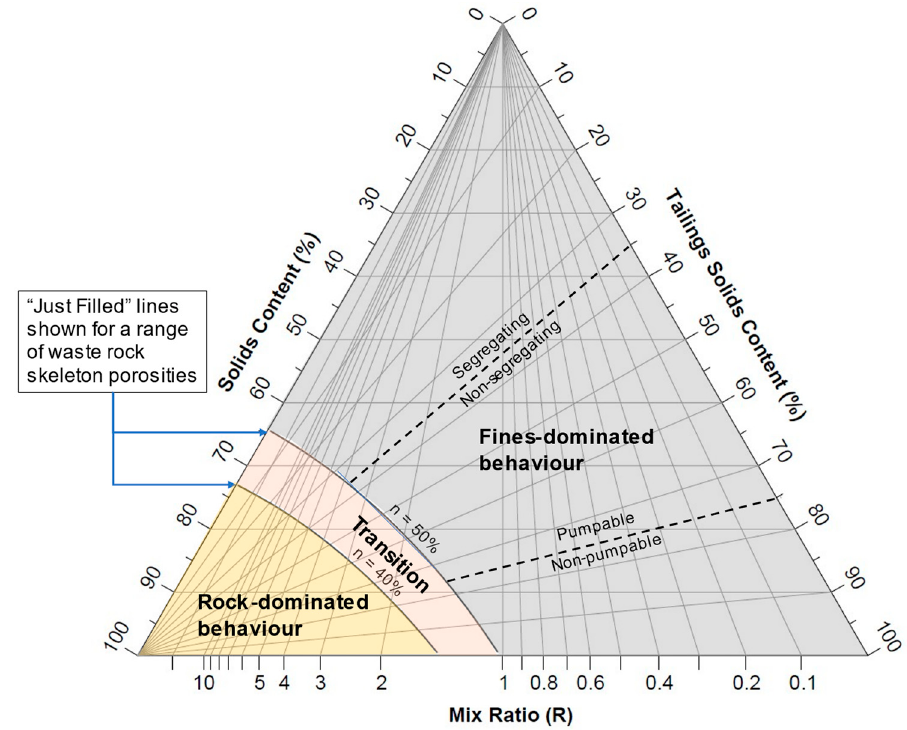
Figure 6. Ternary diagram showing blend configuration vs. mix ratio for fine tailings–waste rock blends.